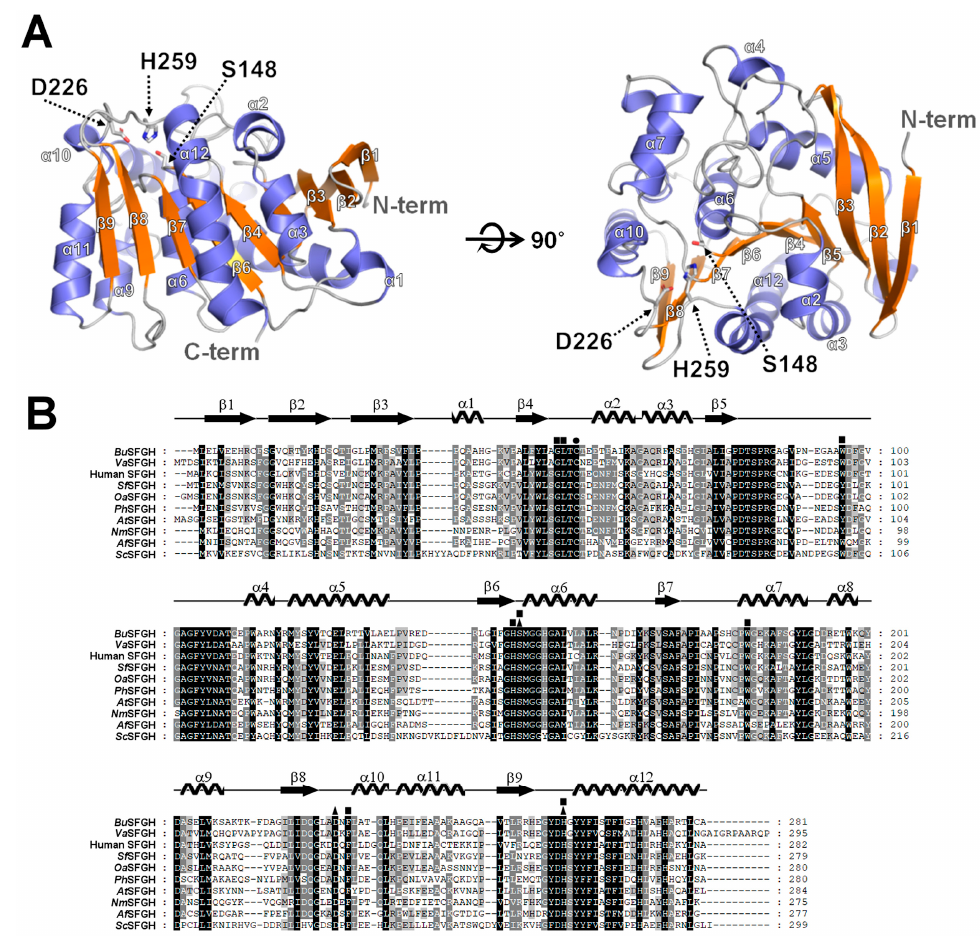
Figure 3. Crystal structure and multiple sequence alignment of Burkholderiaceae sp. S-formylglutathione hydrolase ( Bu SFGH). ( A ) Ribbon representation of Bu SFGH structure. The α -helices and β -strands are colored slate blue and orange, respectively. The conserved catalytic triad of Ser148, Asp226, and His259 is shown using a stick model. ( B ) Multiple sequence alignment of Bu SFGH (NCBI acces- sion code WP_062000720) with selected structural homologs including S-formylglutathione hydrolase from Variovorax sp. PAMC 28,711 ( Va SFGH; NCBI accession code WP_068632277; PDB code 7YVT), S-formylglutathione hydrolase from Homo sapiens (human SFGH; UniProtKB code P10768; PDB code 3FCX), S-formylglutathione hydrolase from Shewanella frigidimarina ( Sf SFGH; UniProtKB code Q07XK4; PDB code 6JZL), S-formylglutathione hydrolase from Oleispira antarctica ( Oa SFGH; UniPro- tKB code D0VWZ4; PDB codes 3I6Y and 3S8Y), S-formylglutathione hydrolase from Pseudoalteromonas haloplanktis ( Ph SFGH; UniProtKB code Q3IL66; PDB code 3LS2), S-formylglutathione hydrolase from Arabidopsis thaliana ( At SFGH; UniProtKB code Q8LAS8), S-formylglutathione hydrolase from Neisseria meningitidis ( Nm SFGH; UniProtKB code Q9JZ43; PDB code 4B6G), S-formylglutathione hydrolase from Agrobacterium fabrum ( Af SFGH; UniProtKB code A9CJ11; PDB code 3E4D), and S-formylglutathione hydrolase from Saccharomyces cerevisiae ( Sc SFGH; UniProtKB code P40363; PDB codes 3C6B, 4FLM and 4FOL). The catalytic triad residues are indicated with black trian- gles. The conserved Cys55 residue is marked as a black circle. The p-NA (p-nitrophenyl acetate) interacting residues in the p-NA-bound Bu SFGH docking model structure are indicated as black squares. Secondary structures obtained from the crystal structure of Bu SFGH are presented above the aligned sequences.